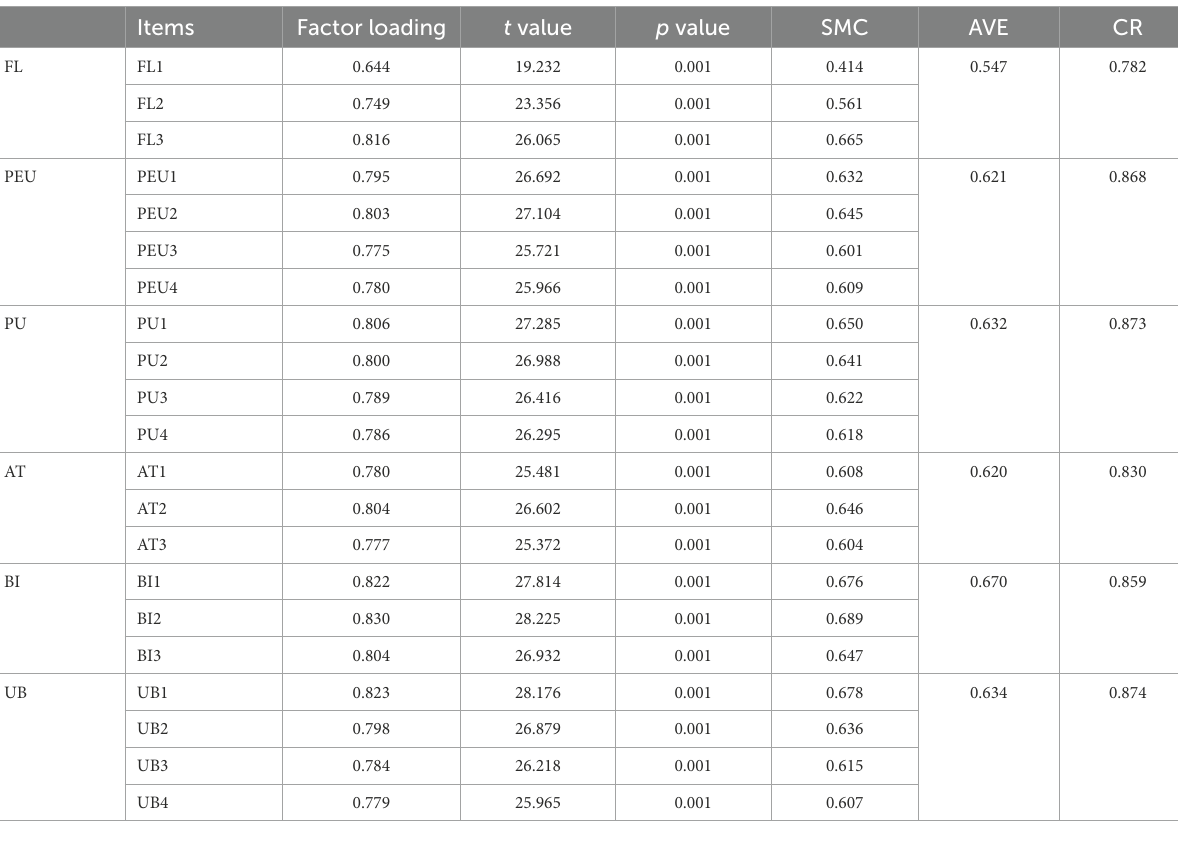
TABLE 7 Validation of convergent validity.